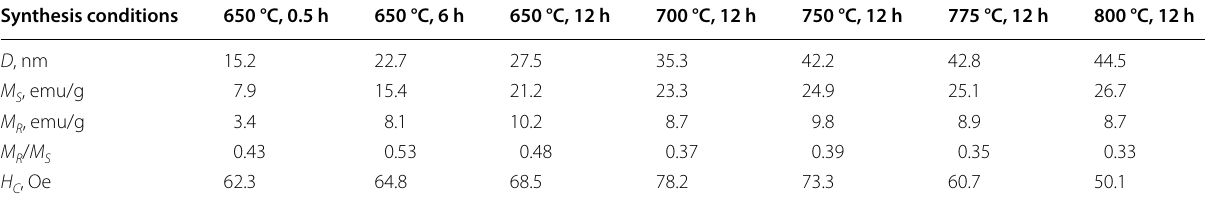
M S , saturation magnetization; M R , remanent magnetization; H C , coercivity; and M R / M S , squareness ratio